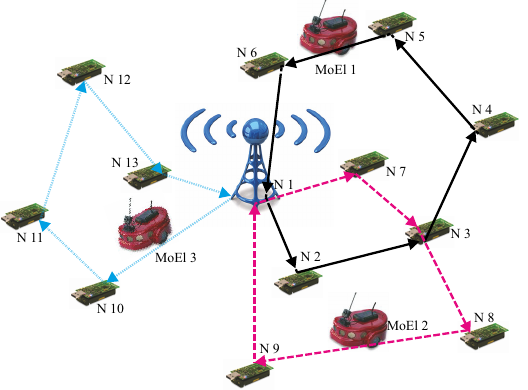
Figure 1. Data Mule Concept with 3 MoEls and 13 static nodes ( M = 3, N =